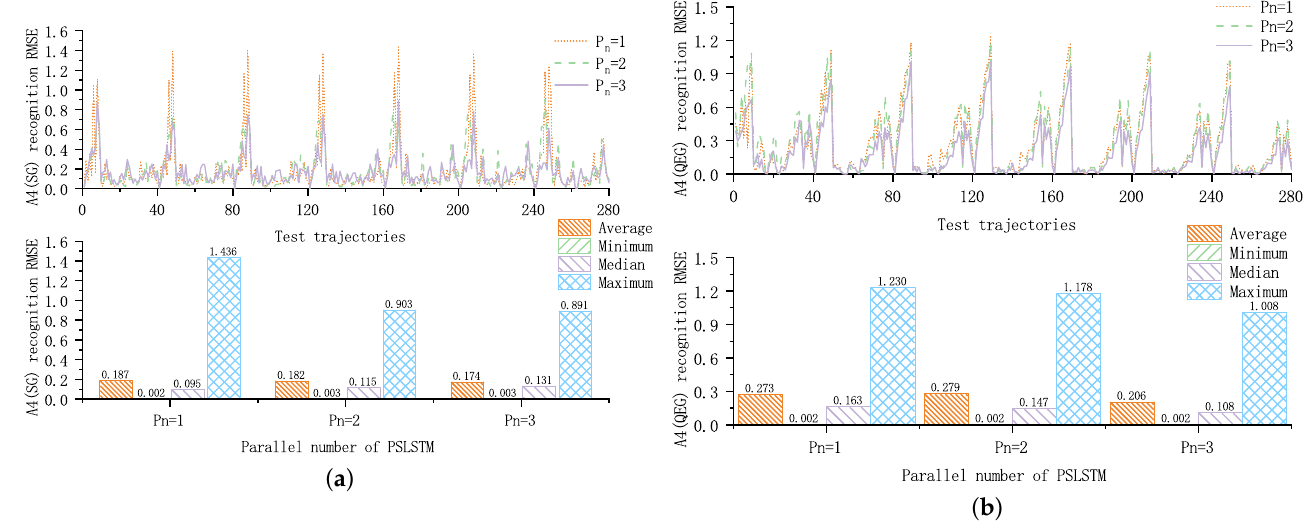
Figure 10. Recognition error of A4: ( a ) is the A4 ( SG ) recognition error curve and ( b ) is the A4 ( QEG ) recognition error